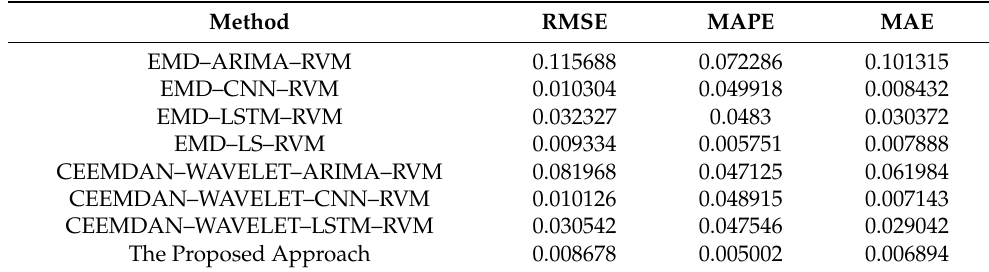
Table 1. Comparison of evaluation